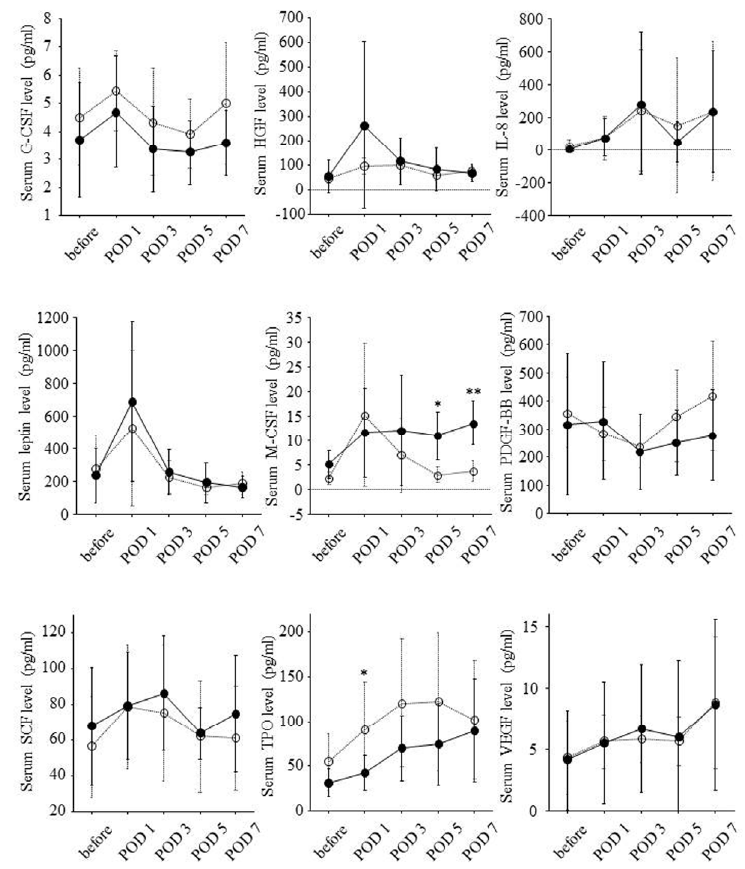
Figure 5. Associations of remnant liver volume per body weight on POD 0 with serial changes of serum levels of nine growth factors during the clinical course. Solid and dotted lines show serial changes of serum levels of each growth factor in eight patients with remnant liver volume per body weight on POD 0 of 10 cm 3 /kg or less and the other eight patients with remnant liver volume per body weight on POD 0 >10 cm 3 /kg, respectively. Serum levels of each growth factor before hepatectomy and on POD 1, 3, 5 and 7 were expressed as mean ± standard deviation. Before: before partial